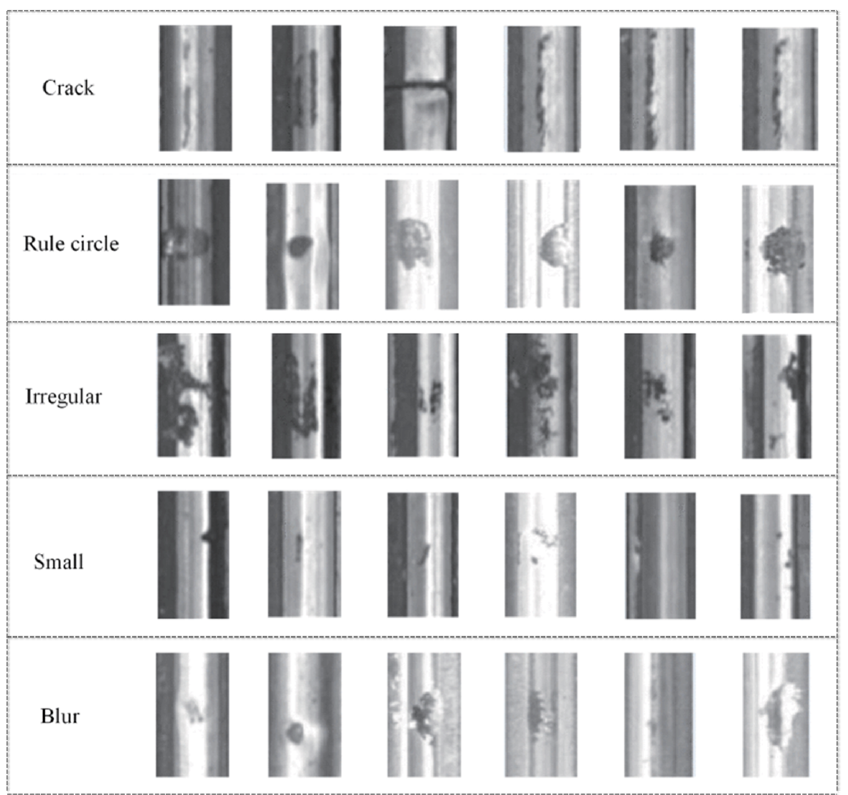
Figure 3. Several types of rail surface defect images. Reproduced with permission from IEEE